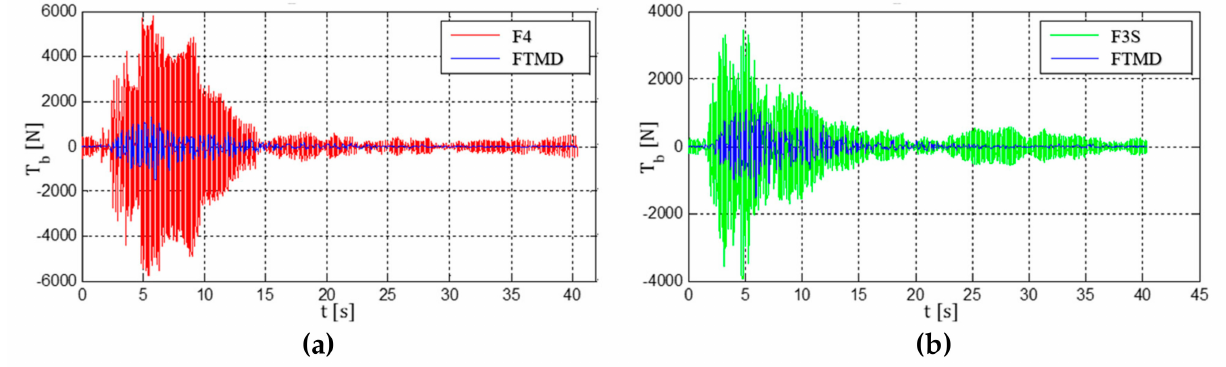
Figure 18. NE—time history of the base shear for Kobe earthquake at given intensity level, PGA = 0.18 g: ( a ) FTMD vs. F4 configuration, ( b ) FTMD vs. F3S